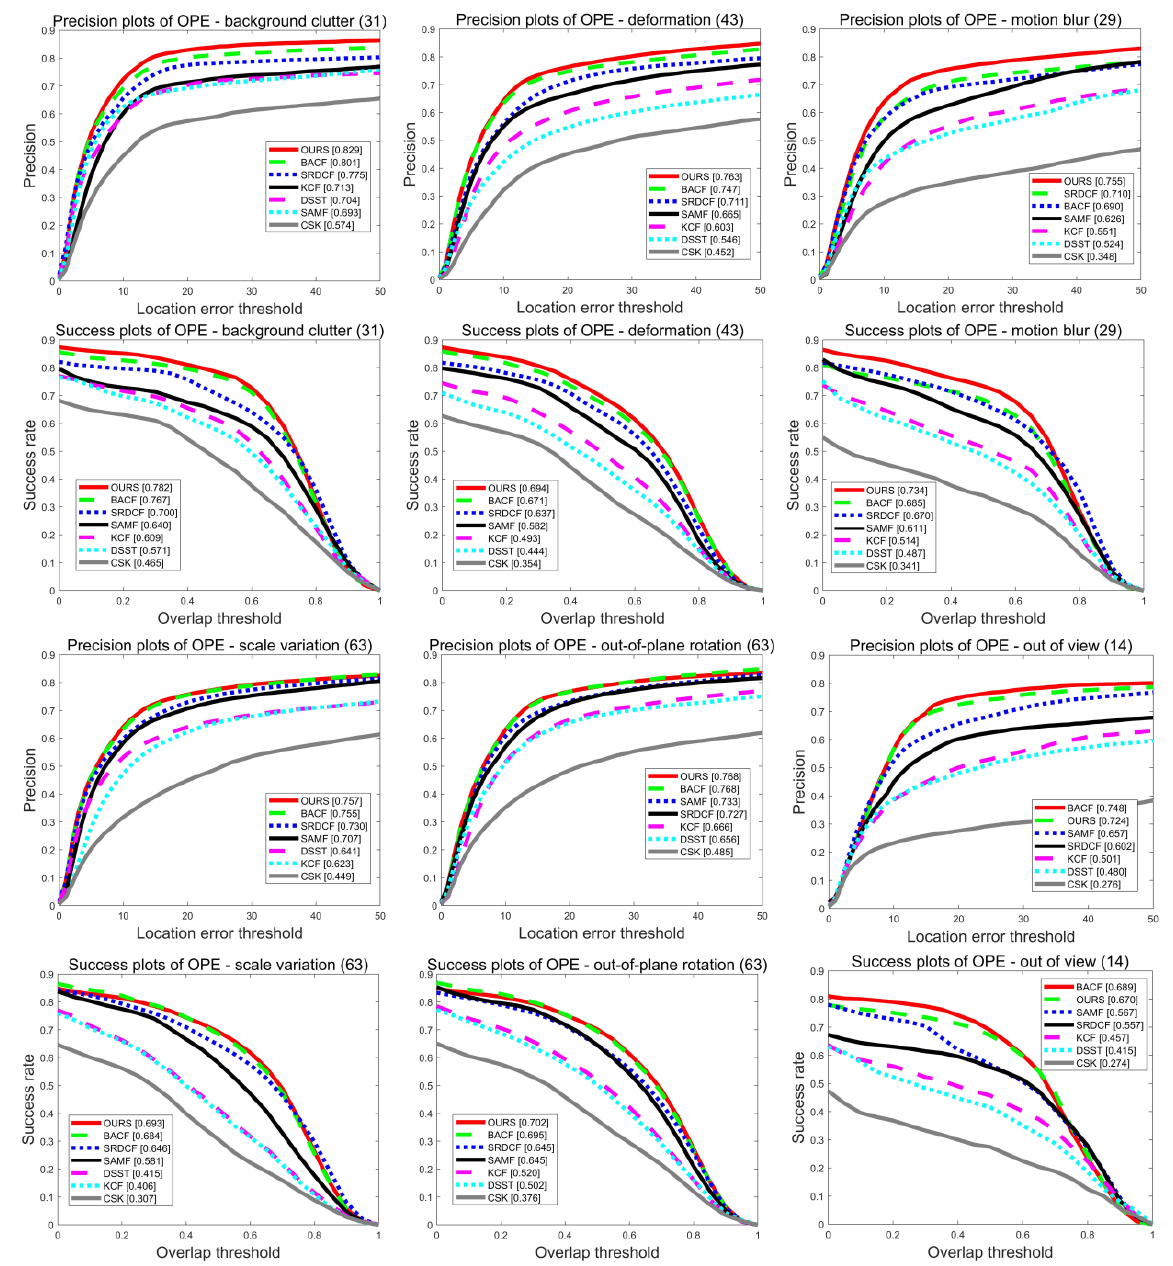
Figure 5. Accuracy and success rate plots of 7 tracking algorithms tested on the BC, DEF, MB, SC, OPR, and OV attributes of the OTB2015 dataset.